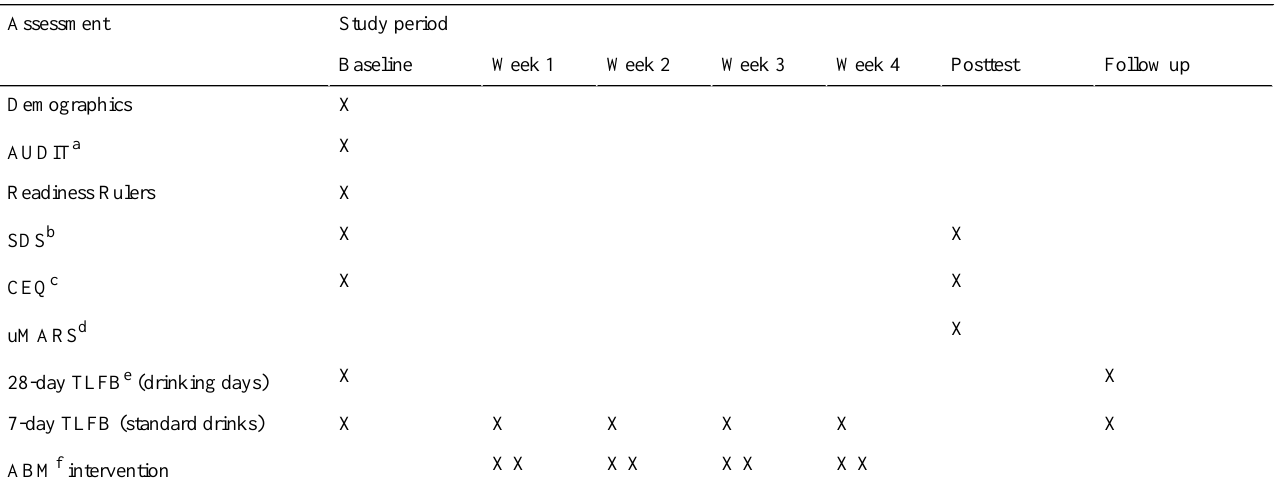
Table 1. Overview of SWIPE app study measures and schedule.